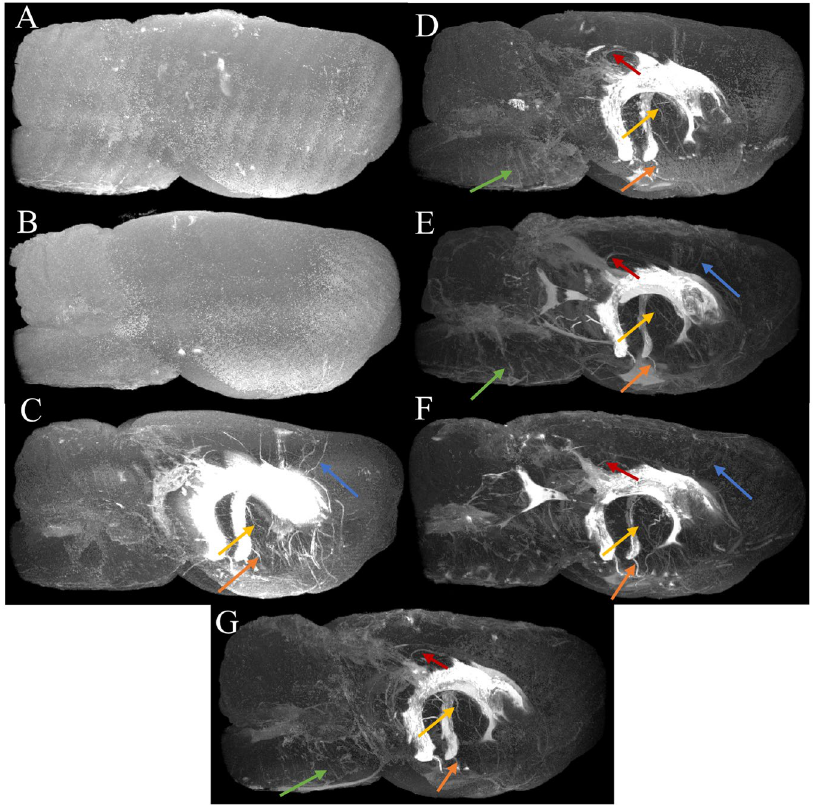
Figure 7. 2D maximum intensity projection of the reconstructed 3D perivascular network from five rats registered to the template rat brain atlas. ( A , B ) Results of the analysis applied to the naïve rats and ( C – G ) to the tracer infused rats. Vessels with perivascular spaces that appear to be common in different rats are highlighted using colored arrows. PVS connecting lateral ventricles to the dorsal brain surface (red and blue arrow), ventral brain surface (orange arrow), deep brain structures (yellow arrow) are highlighted along with PVS in the brainstem (green arrow). 3D animations are provided in the supplemental